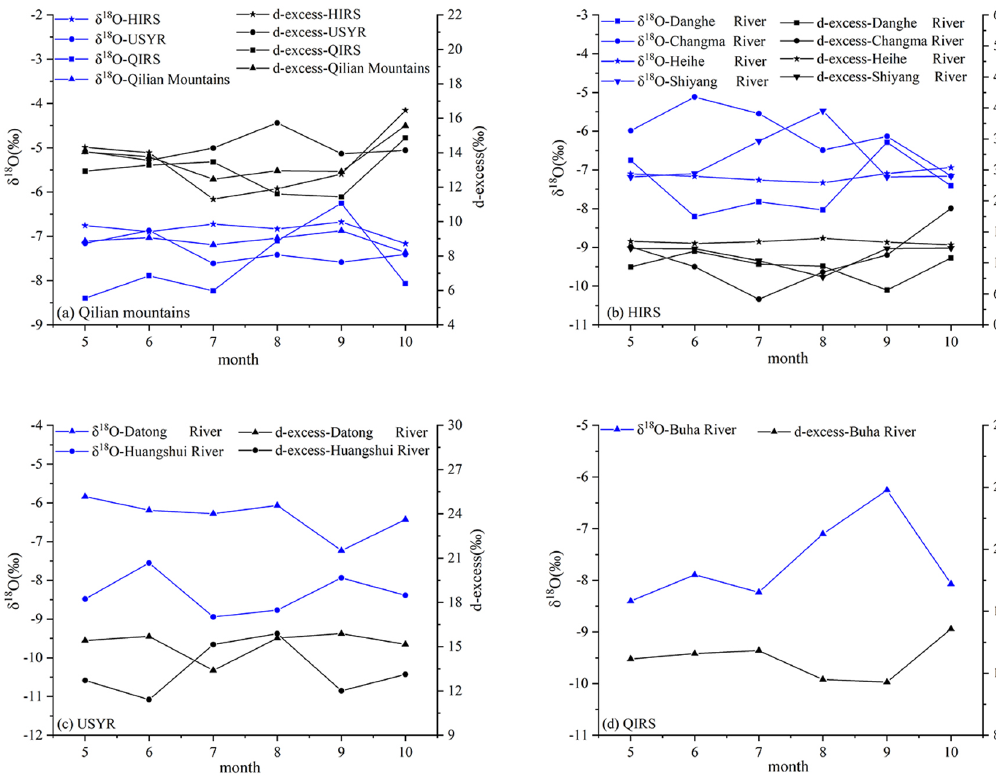
Figure 4. Temporal variation of stable isotopes in supra-permafrost water in the Qilian Mountains.